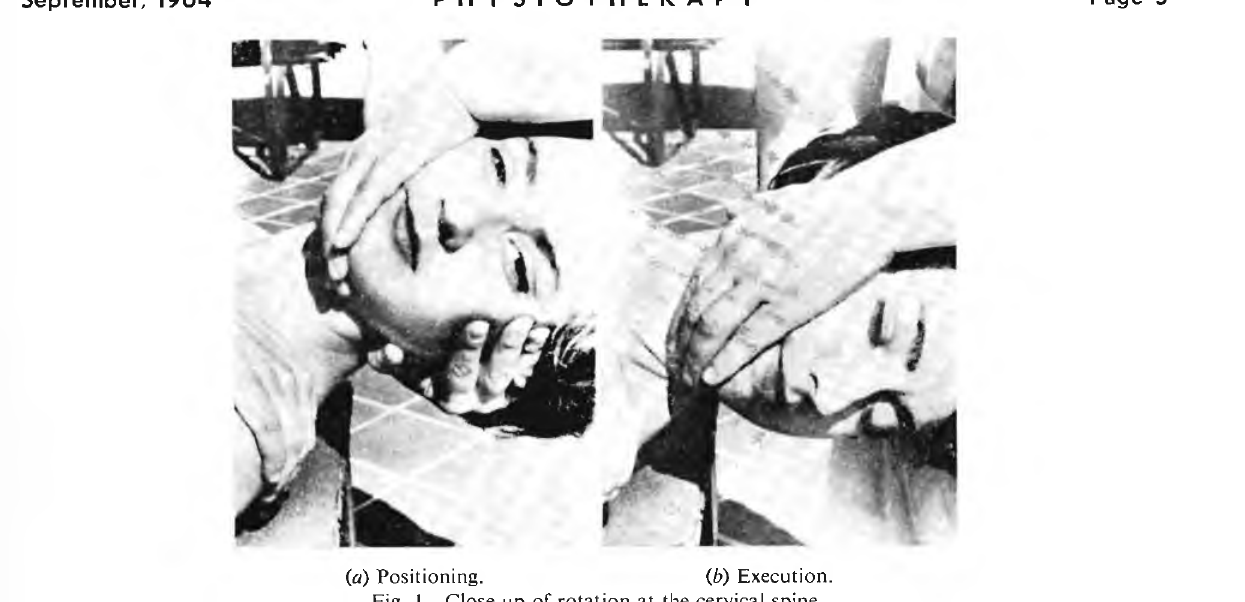
Fig. 1 Close-up of rotation at the cervical